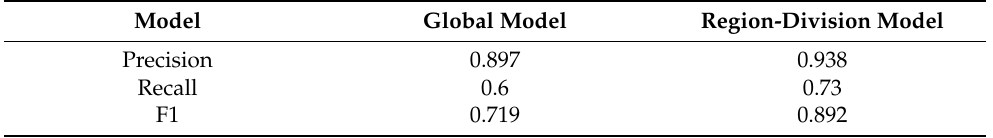
Table 4. Precision, recall, and F1